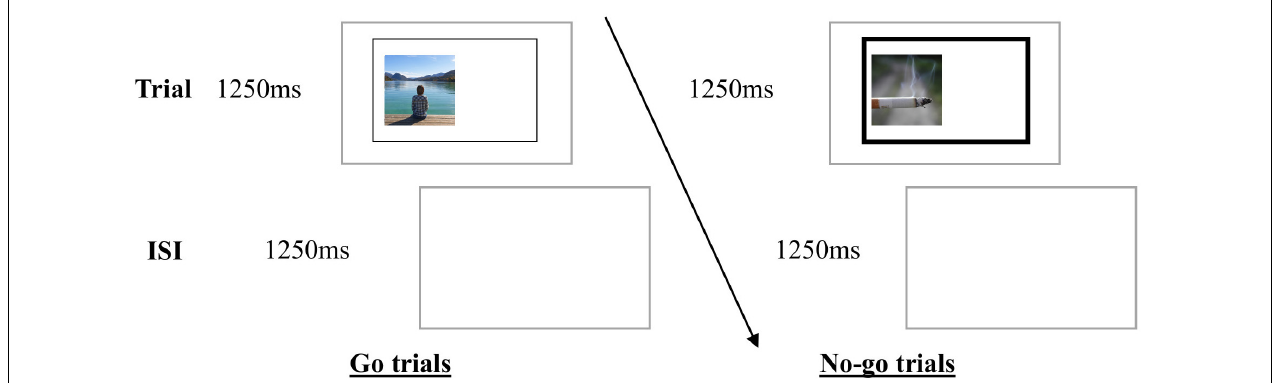
FIGURE 1 | Go/no-go ICT and Active Control Training. Images were presented within a rectangle, followed by an inter-stimulus-interval (ISI). Participants were instructed to indicate as quickly and as accurately as possible the location of an image within the rectangle (left or right) by pressing a computer key (C or M, respectively) when the rectangle was not bolded (go trials). However, when the lines of the rectangle were bold (no-go trials), participants were instructed to refrain from responding.